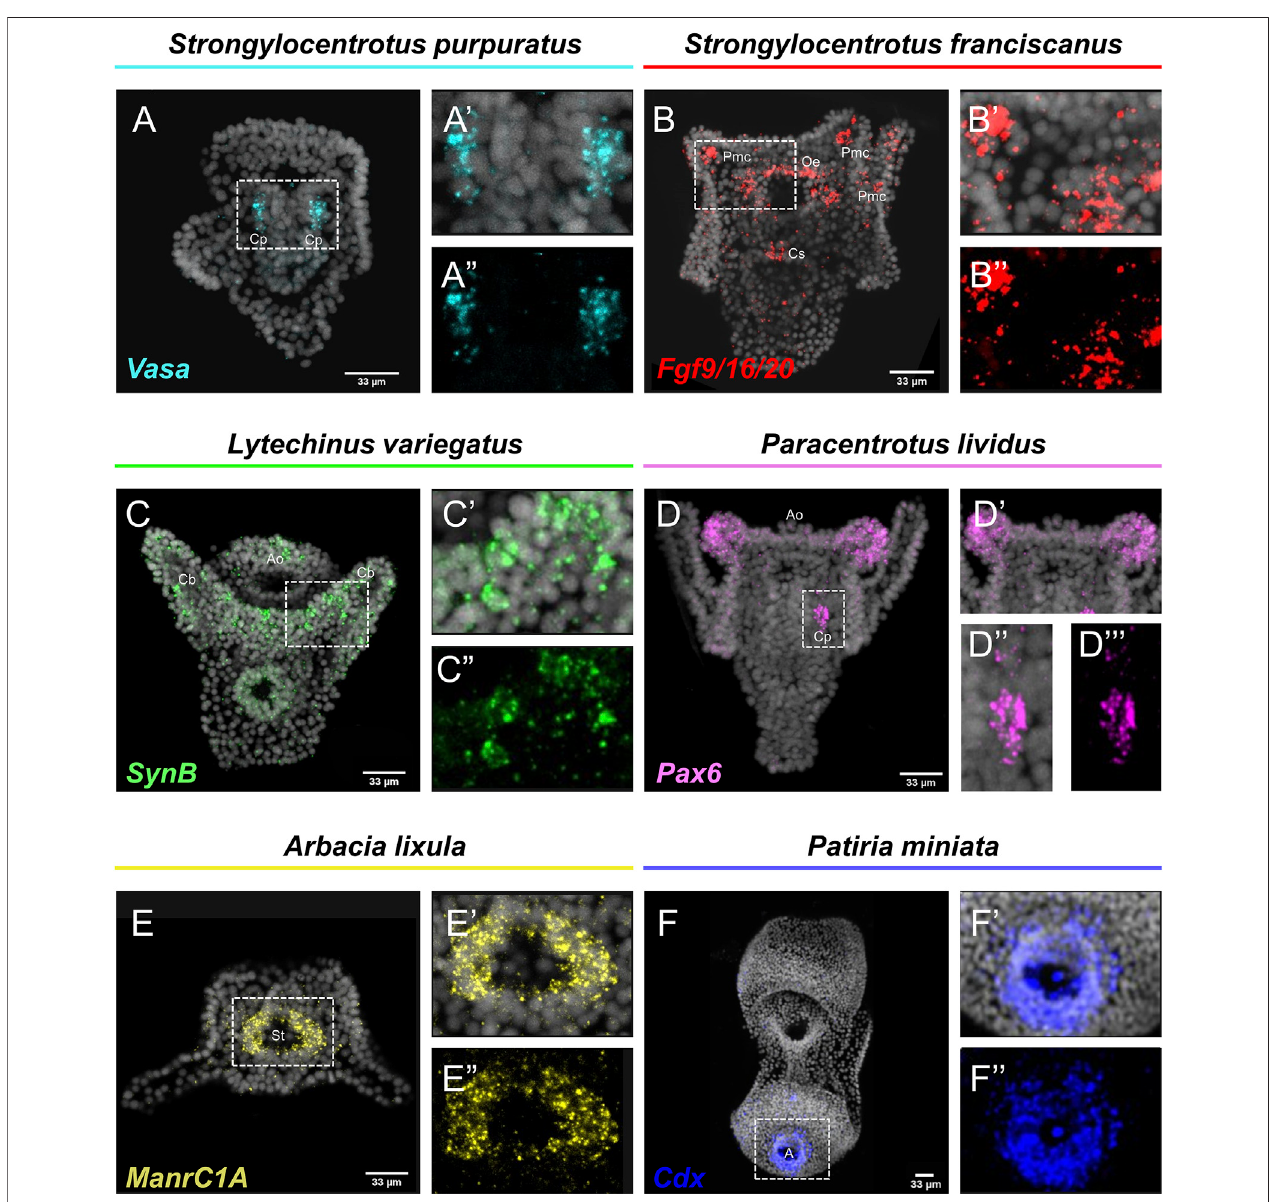
FIGURE 1 | Expression patterns of known gene markers in echinoderm representatives through FISH. FISH of S. purpuratus larva with antisense probe for Vasa (A – A ’’ ) , S.franciscanus larvawithantisenseprobefor Fgf9/16/20 (B – B ’’ ) , L.variegatus larvawithantisenseprobefor SynB (C – C ’’ ) , P.lividus larvawithantisense probe for Pax6 (D – D ’’ ) , A. lixula with antisense probe for ManrC1A (E – E ’’ ) and P. miniata larva with antisense probe for Cdx (F – F ’’ ) . Nuclei are stained with DAPI (in grey). All images are stacks of merged confocal Z sections. A, Anus; Ao, Apical organ; Cb, Ciliary band; Cp, Coelomic pouches; Cs, Cardiac sphincter; Oe, Oral ectoderm; Pmc, Primary mesenchyme cell; St,